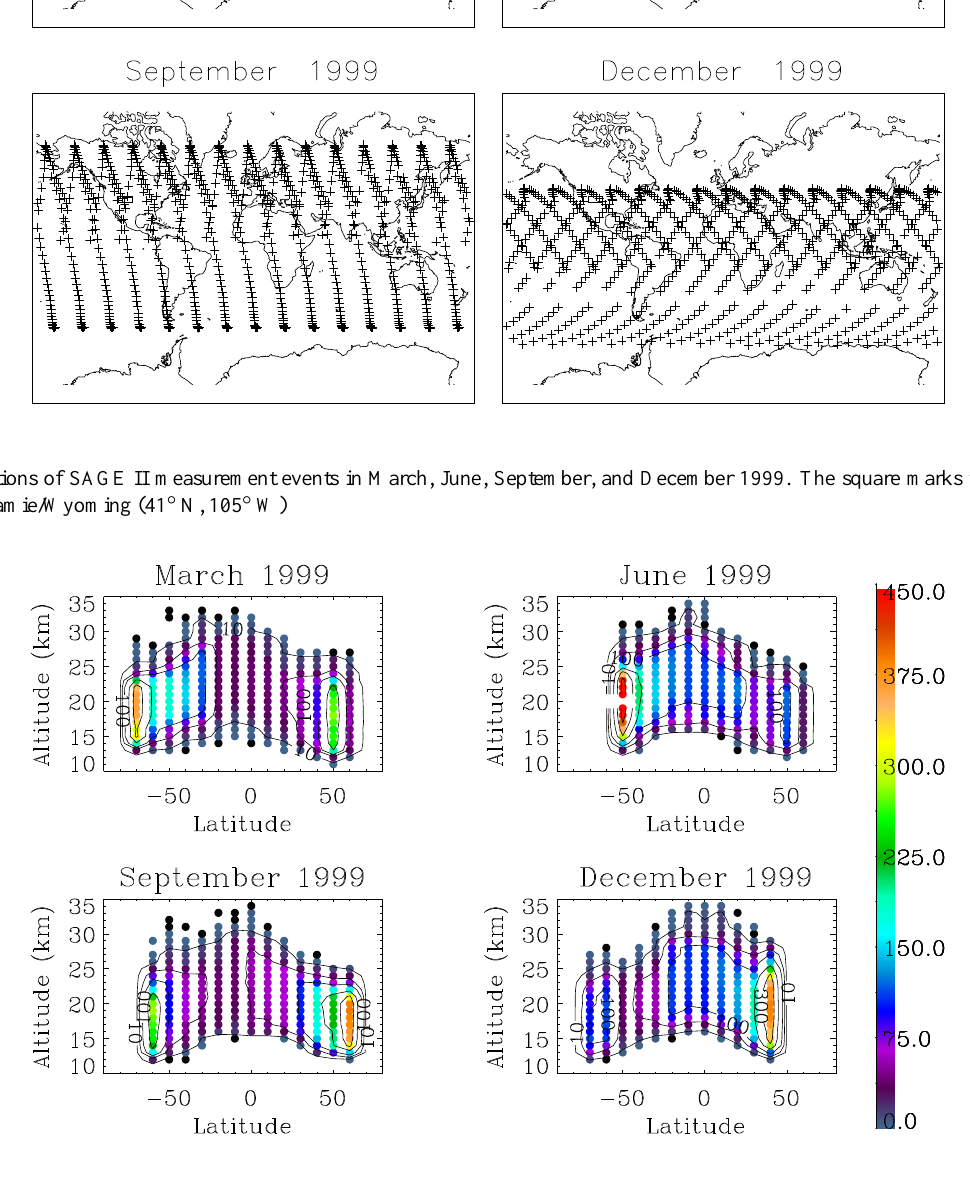
Fig. 17. Number of measurements per 10 ◦ latitude and 1km altitude grid box. Each grid box is represented by a spot. Contours are marked for 10, 50, 100, 200, and 300 counts.